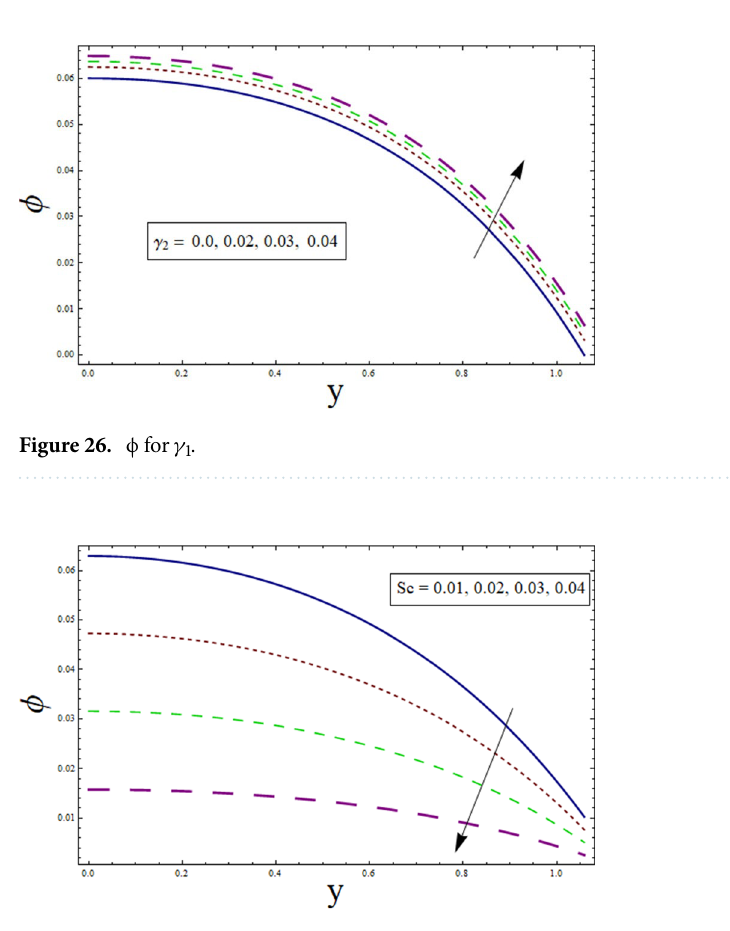
Figure 27. ϕ for Sc .